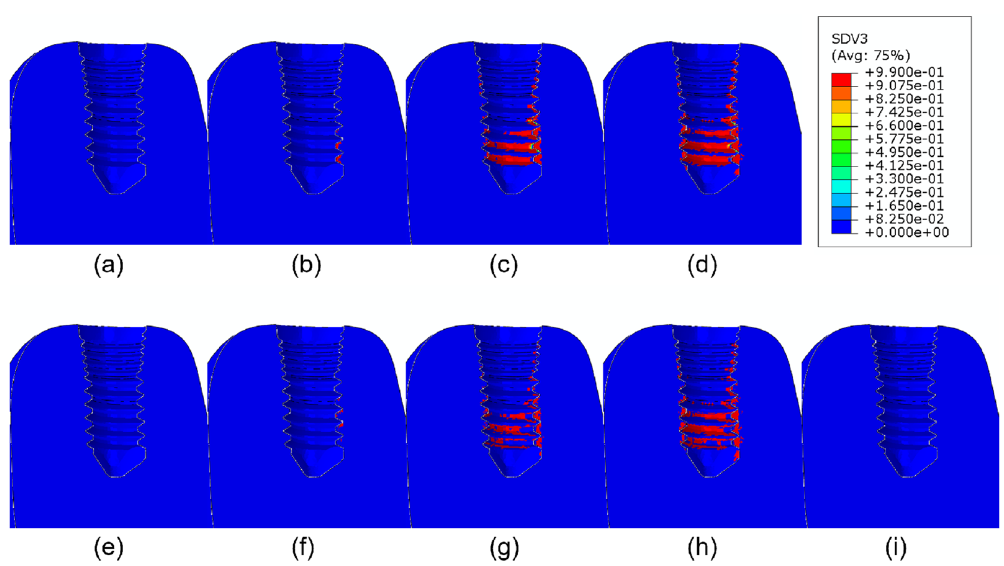
Figure 8. Damage distribution after 540 days of simulation for different doses of ( a ) 0.1, ( b ) 0.3, ( c ) 1.0, ( d ) 3.0 mg/kg of denosumab and doses of ( e ) 0.25, ( f ) 0.5, ( g ) 1.0, ( h ) 2.0 mg of bisphosphonates and ( i ) control